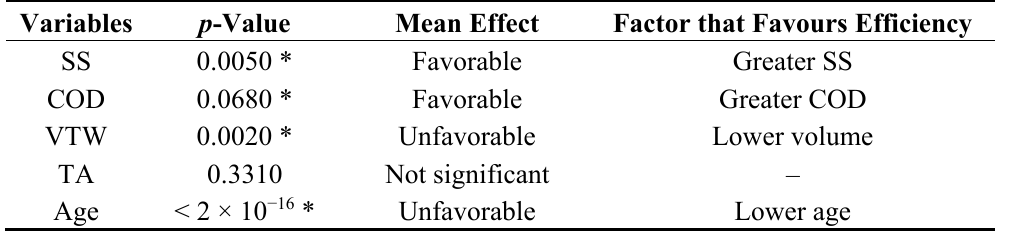
Table 4. Non-parametric significance test. M1 (order- m conditional efficiency)